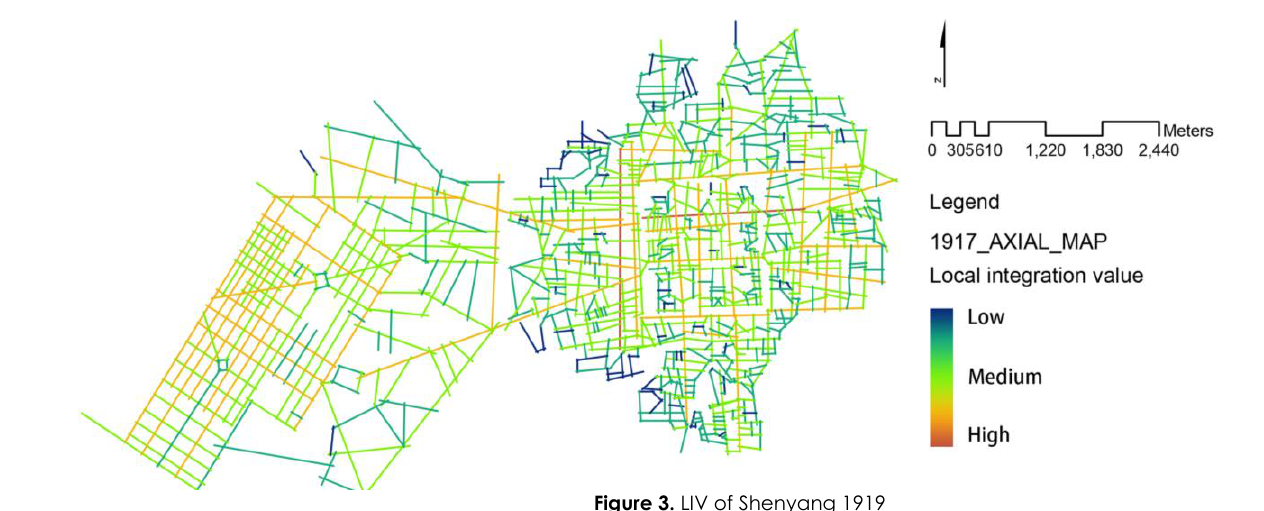
Figure 3. LIV of Shenyang